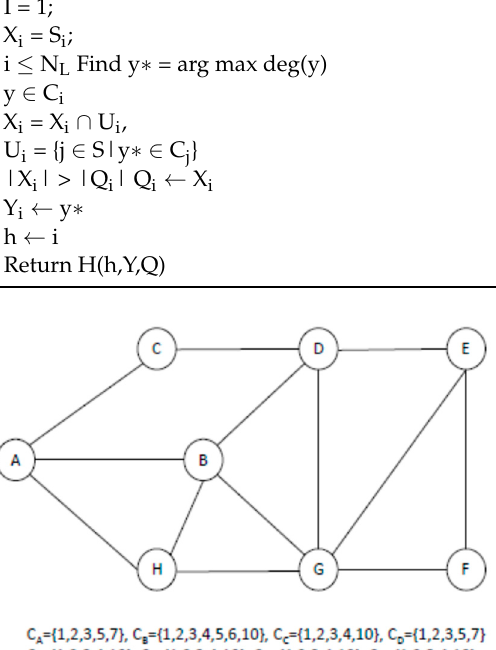
Figure 3. An Example of a CR-WMN.